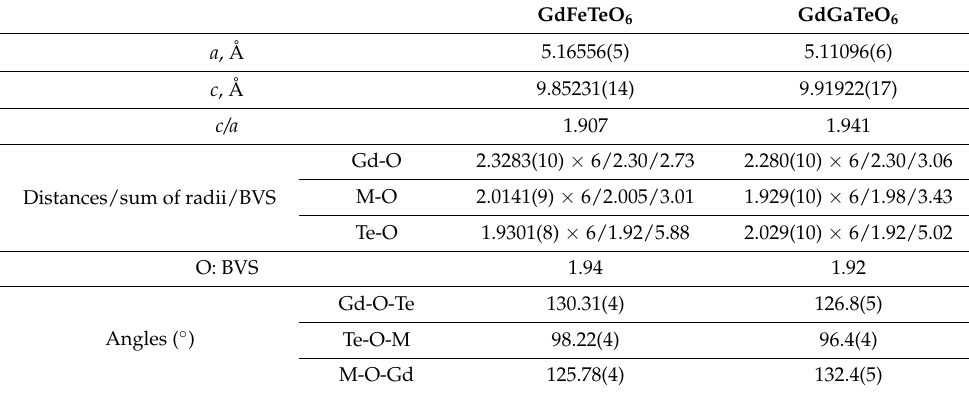
Figure 1. Results of the Rietveld refinement for GdFeTeO 6 ( top ) and GdGaTeO 6 ( bottom ). Crosses, experimental data; red line, calculated profile; bottom blue line, difference profile; vertical bars, Bragg angles. Table 1. Lattice parameters, bond lengths (Å), sums of ionic radii [16], bond valence [19] sums (BVS) and bond angles in GdMTeO 6 (M = Fe, Ga).